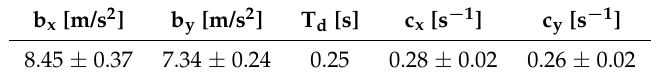
Table 1. Values of the parameters of the potential field implemented to avoid